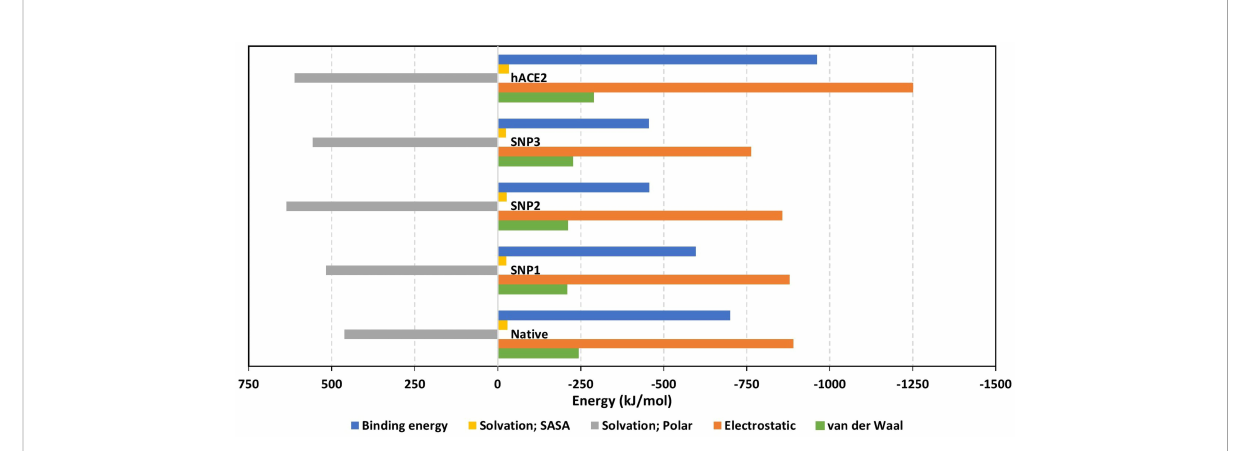
FIGURE 7 Free binding and individual energy terms for the simulated spike RBD/ligand complexes. Values are estimated in terms of kJ/mol ± SE; error bars are hidden for